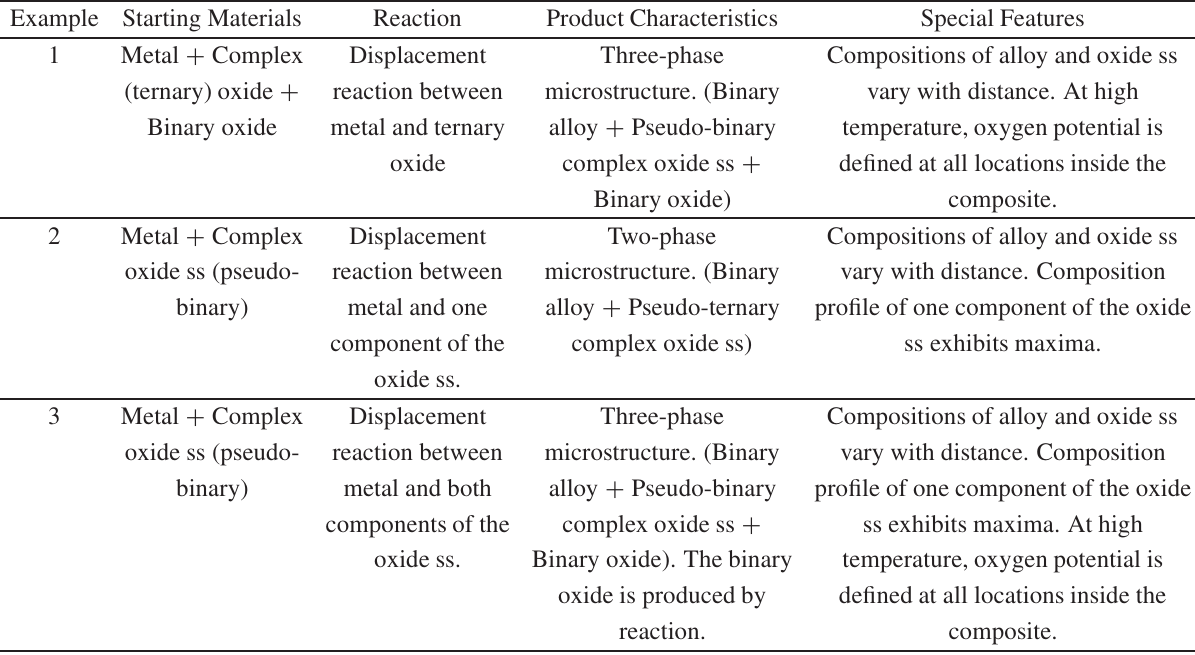
Table 1. Similarities and differences between three composition-graded metal-ceramic composites with complex mi- crostructures prepared by reactive